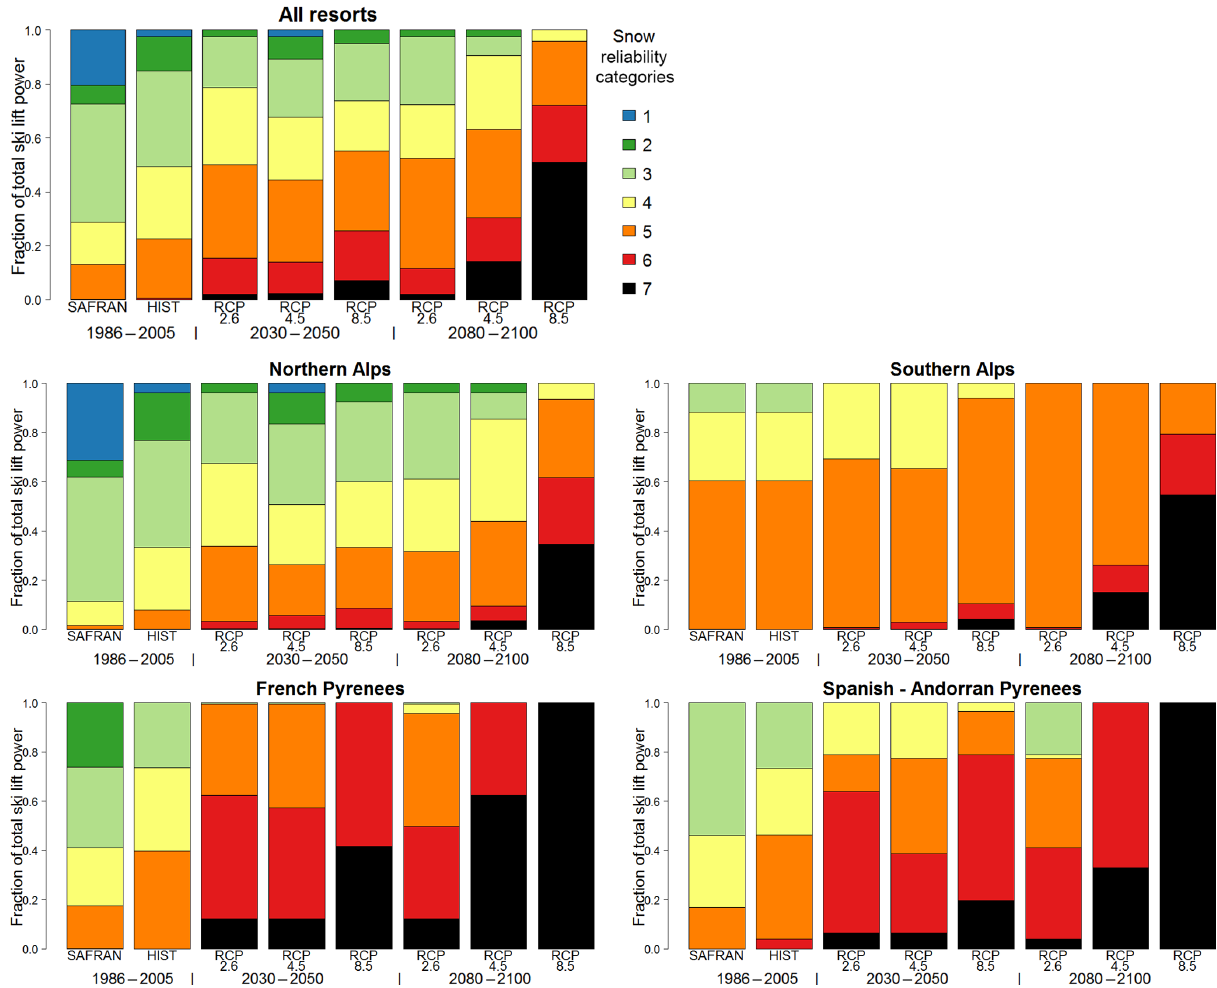
Figure 4. Distribution of the total ski lift power (%) within reliability categories for distinct periods and scenarios (Table